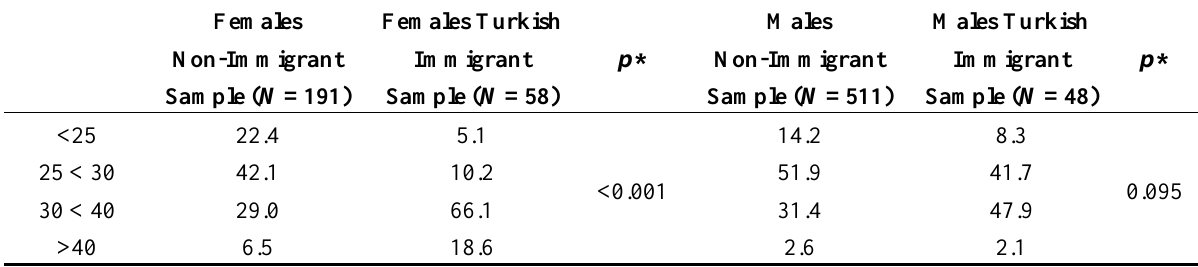
Table 6. Outcome quality: BMI in DMP-subgroup